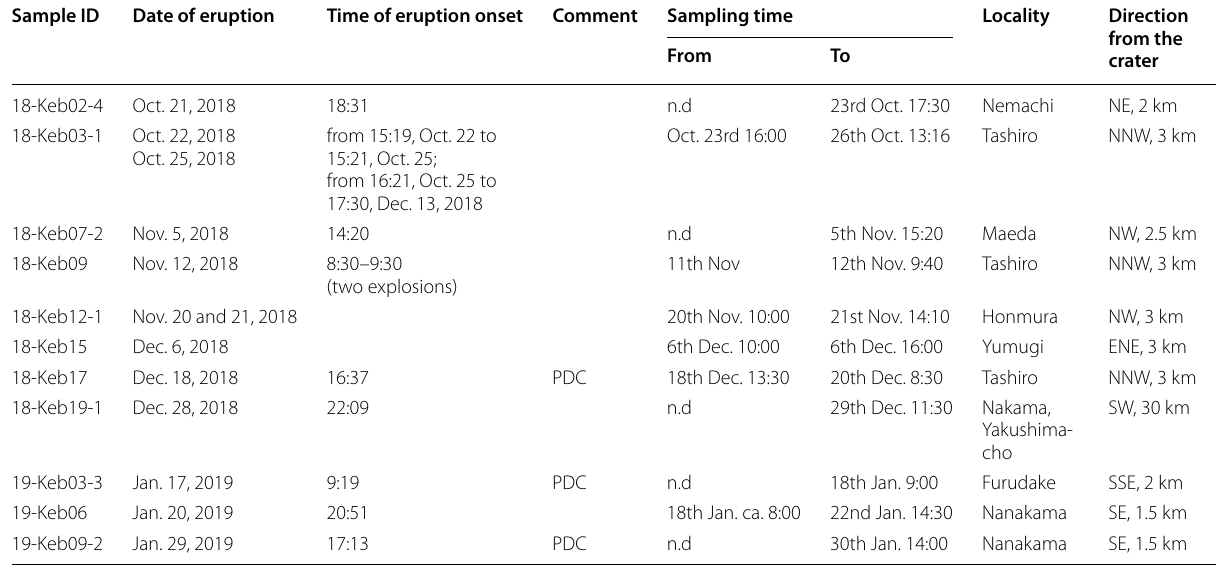
Table 1 Sample collection